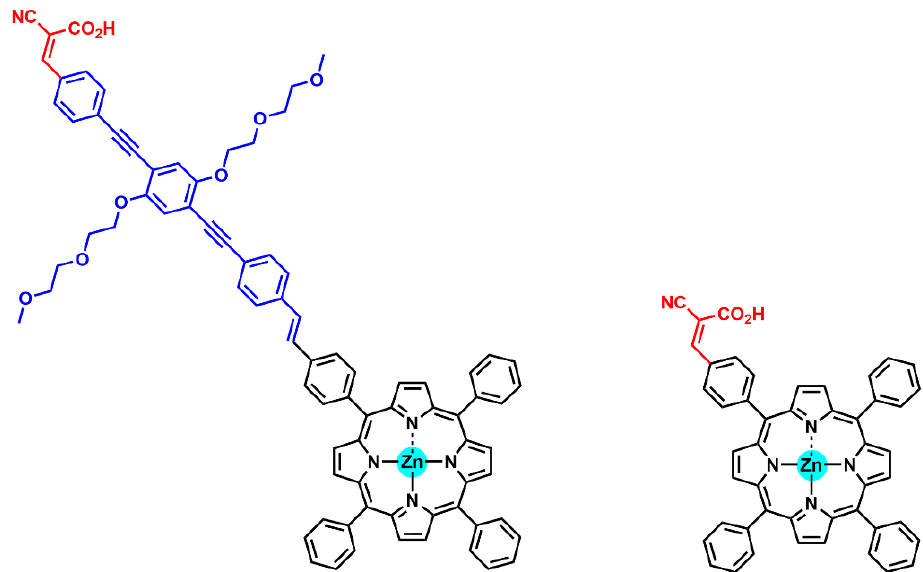
Figure 21. Molecular structures of porphyrin sensitizers differing in the conjugated π -spacer for improved electronic communication between dye photosensitizers and TiO 2 .